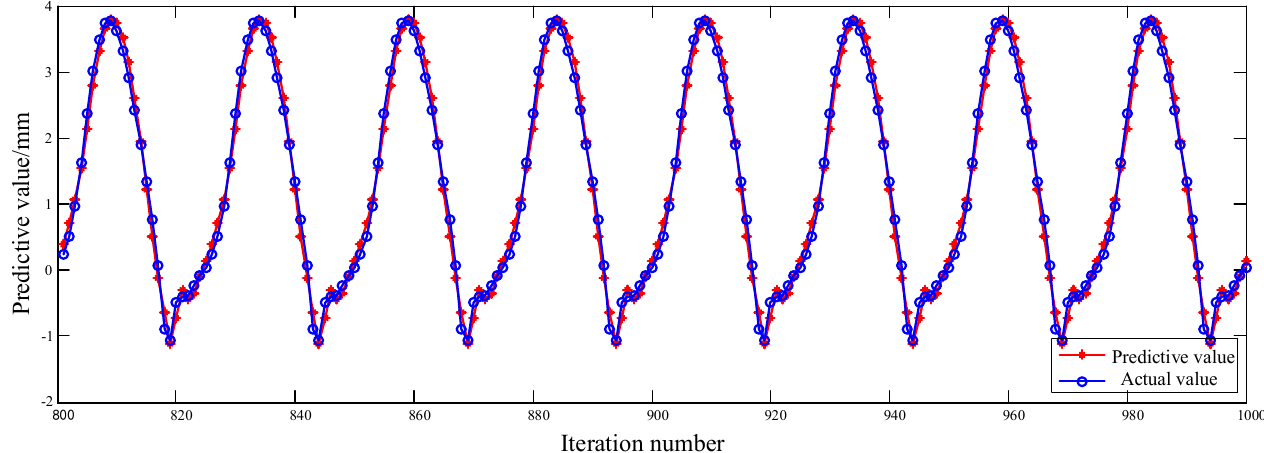
Figure 4. Prediction curve of ICSO-SVM model of nonlinear system.